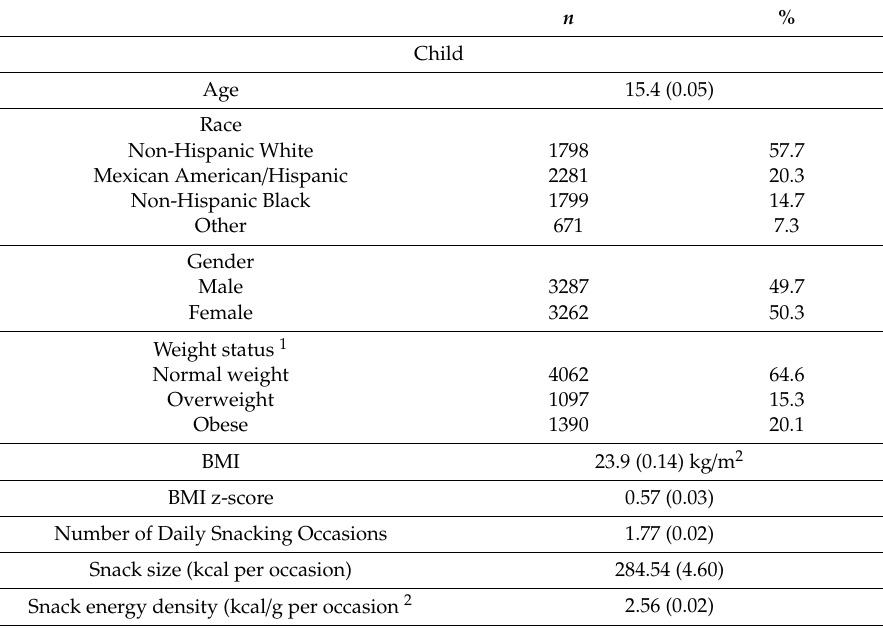
Table 1. Demographic characteristics ( n =